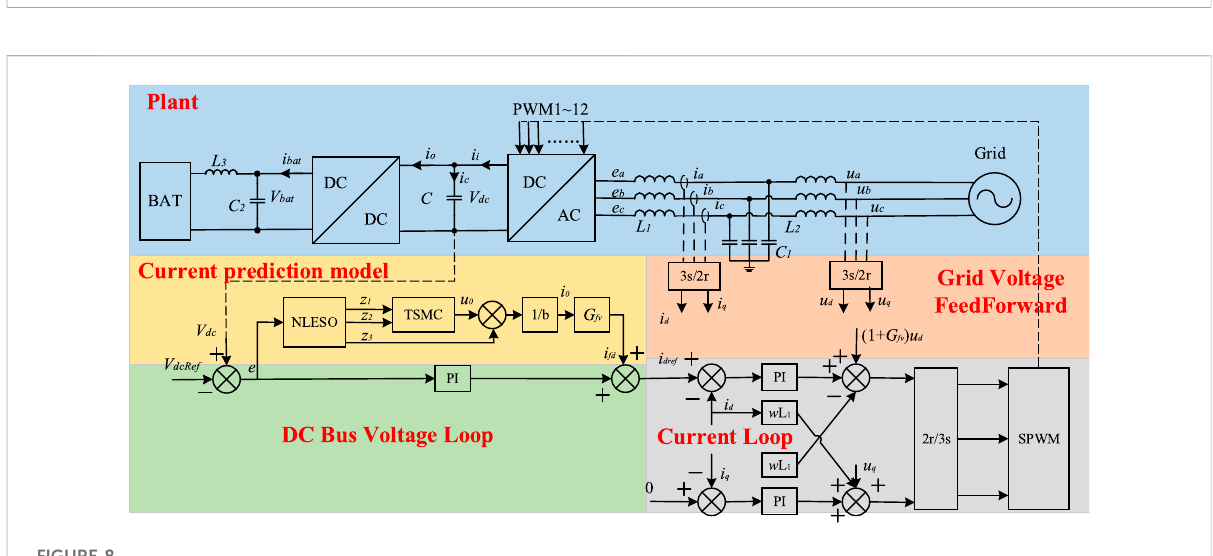
FIGURE 8 System primary circuit topology and loop control block